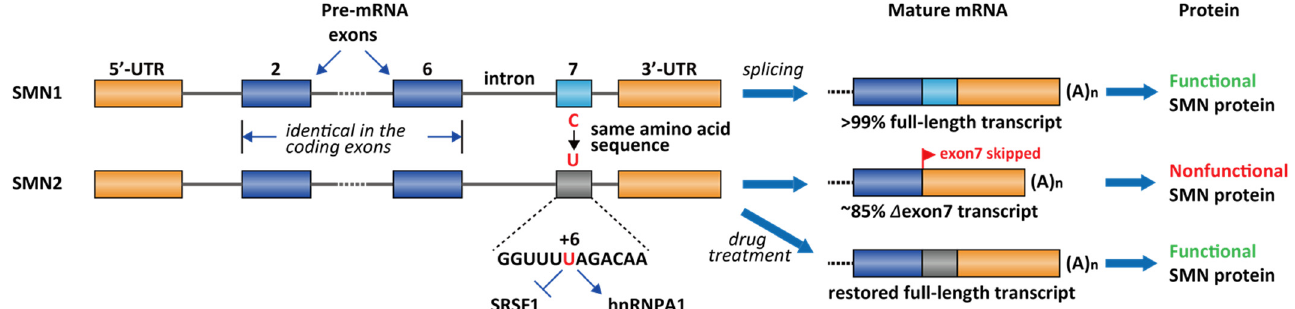
Figure 4. Differential splicing patterns for SMN1 and SMN2. ~85% of the SMN2 transcript has exon 7 skipped due to the C-to-T transition, which mediates the loss of interaction of SRSF1 and gain of the interaction of hnRNPA1. Most type I SMA patients have deleted SMN1 but wildtype SMN2. Nusinersen, RG-7916, and LMI-070 are all interventional therapy to restore exon 7 inclusion in SMN2.